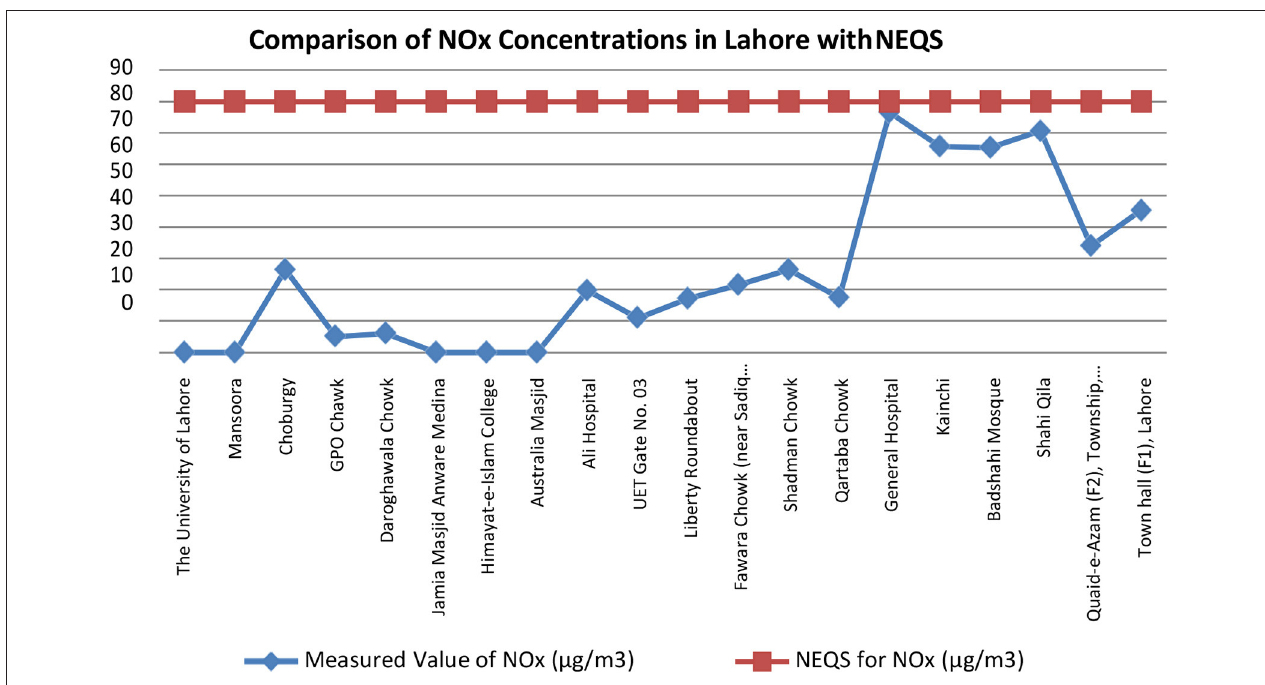
FIGURE 3 | Comparison of NOx concentrations in Lahore with